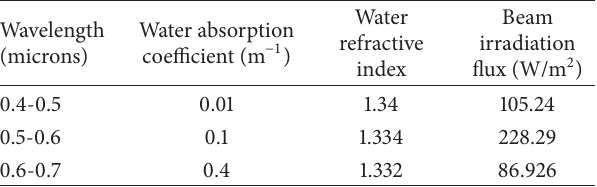
Table 1: Beam irradiation flux from the radiator and radiative properties of